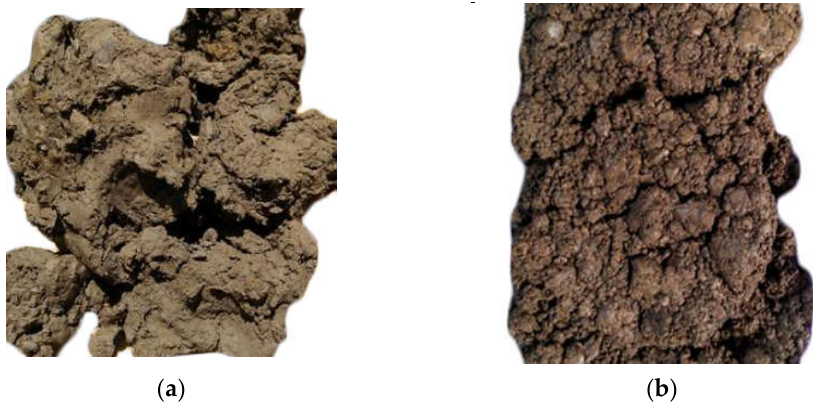
Figure 3. Photograph of soil sample. ( a ) clayey soil sample; ( b ) weathered basalt soil sample.